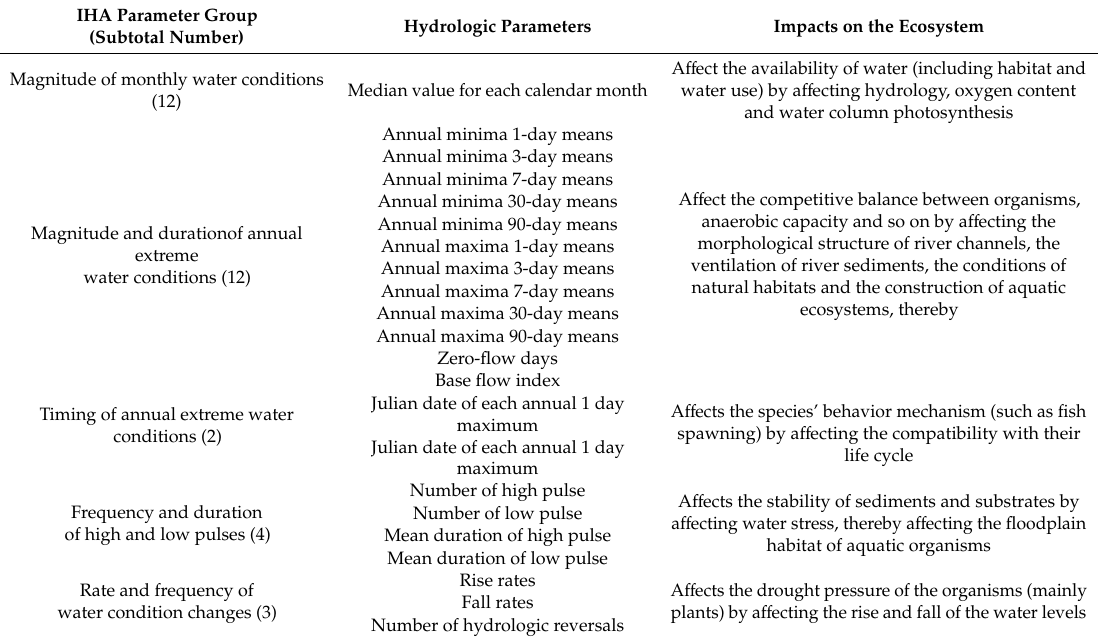
Table 2. Di ff erent groups of the Indicators of Hydrological Alterations (IHA) 33-based indicators and di ff erent impact on the ecosystem of each